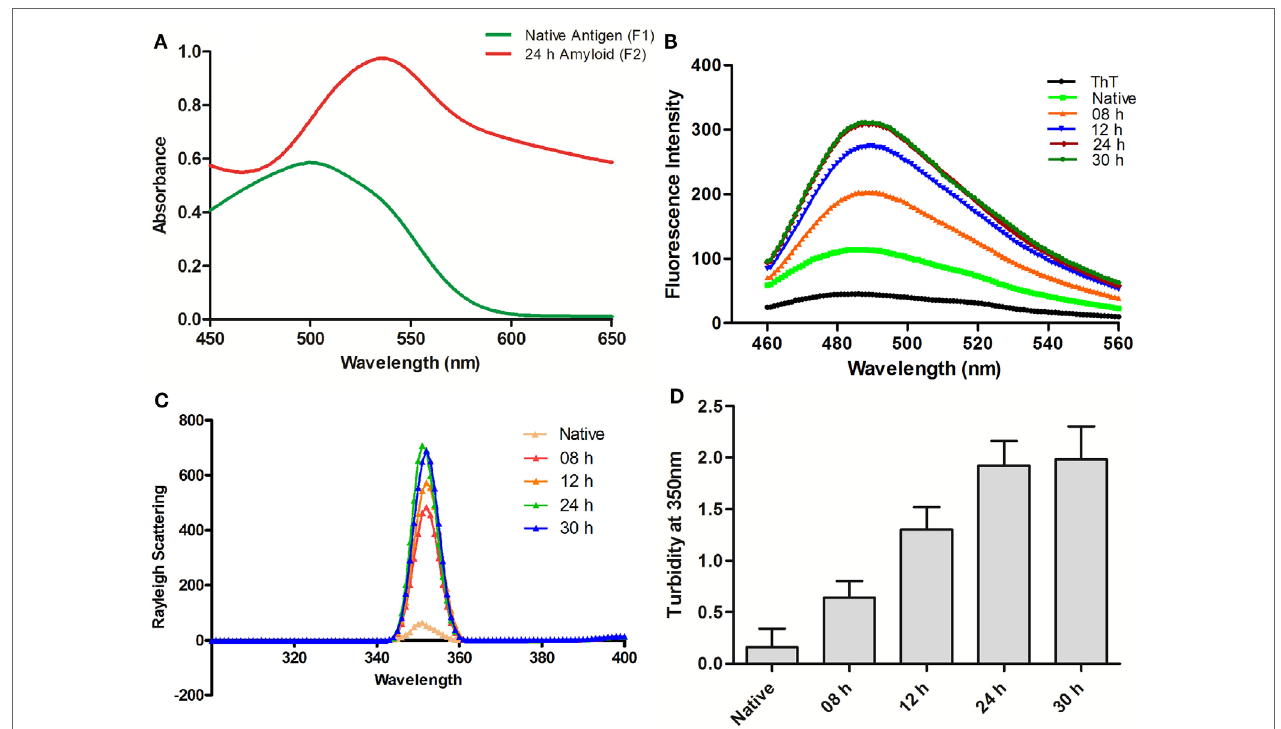
FigUre 1 | Biophysical characterization of Ag85B aggregates. (a) Absorption spectra of Congo Red dye bound to aggregated amyloidal Ag85B. The characteristic spectral “Red Shift” confirms the presence of β -sheet rich amyloidal core. (B) Amyloidal aggregate formation as monitored by Thioflavin-T fluorescence spectroscopy. Gradual increase in ThT emission intensities, as obtained by excitation at 450 nm and emission in the range of 460–560 nm, an indication for sequential maturation of Ag85B fibril at various time points. (c) Rayleigh Scattering characteristic at 350 nm for Ag85B aggregates. Data pertaining to various samples obtained from simulated reaction process at various time points confirm that the extended agitation gradually induced aggregation of soluble Ag85B. (D) Turbidity profile of synthesized aggregates. Various aggregated forms of Ag85B (formed at various incubation stages) were also scanned for increase in the turbidity of protein suspension. Error bars exhibit ± standard errors of means ( ± SEM). Three independent experiments were performed for each sample and data are representative of at least two independent experiments with similar